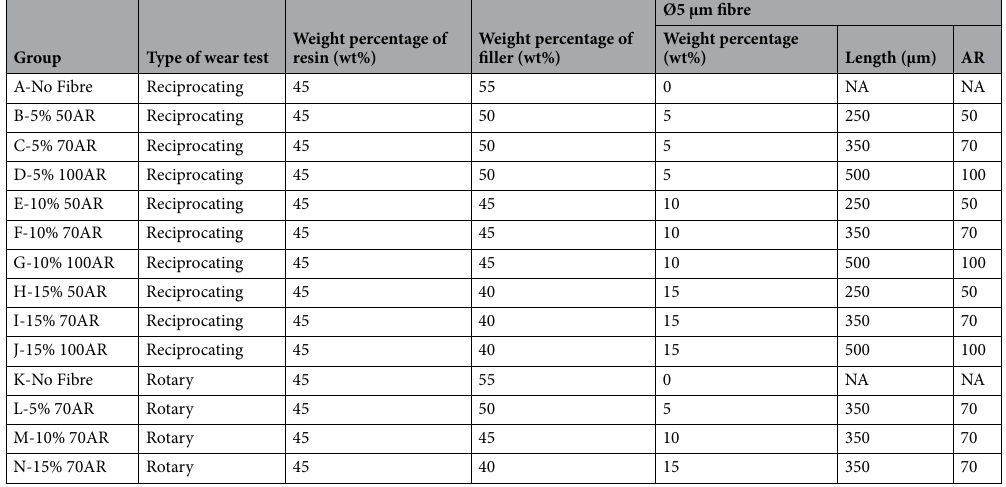
Table 1. Experimental test